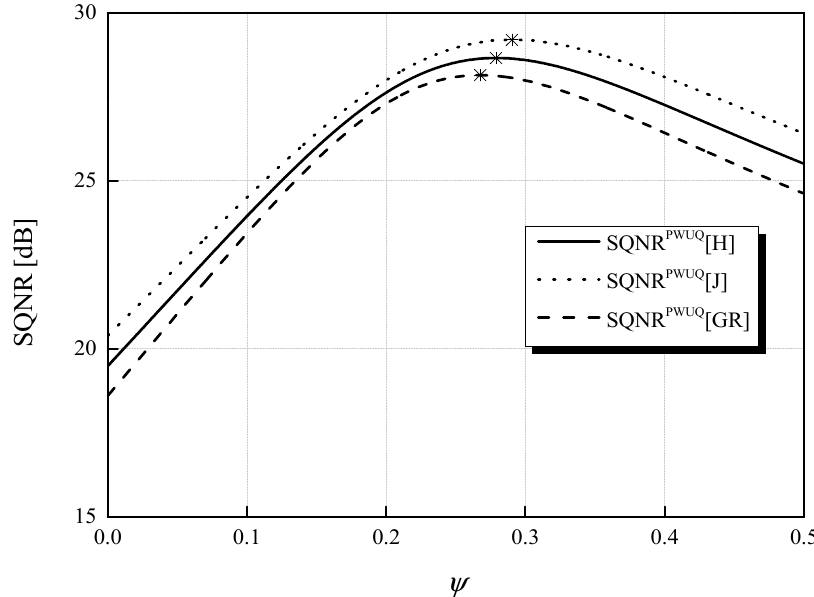
Figure 5. Dependences of SQNR PWUQ on ψ for the three cases considered ( r = 6 bit/sample).